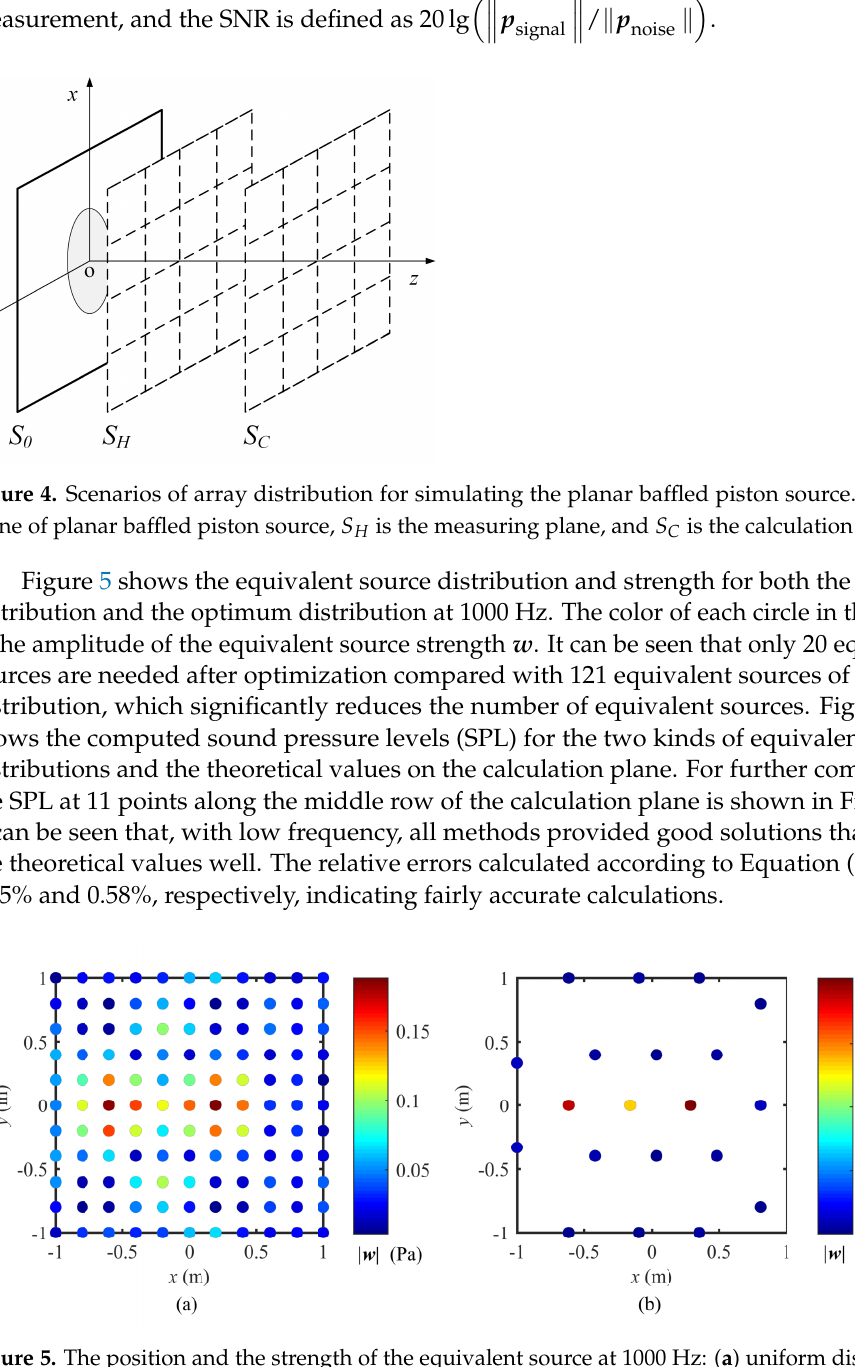
Figure 5. The position and the strength of the equivalent source at 1000 Hz: ( a ) uniform distribution and ( b ) optimum